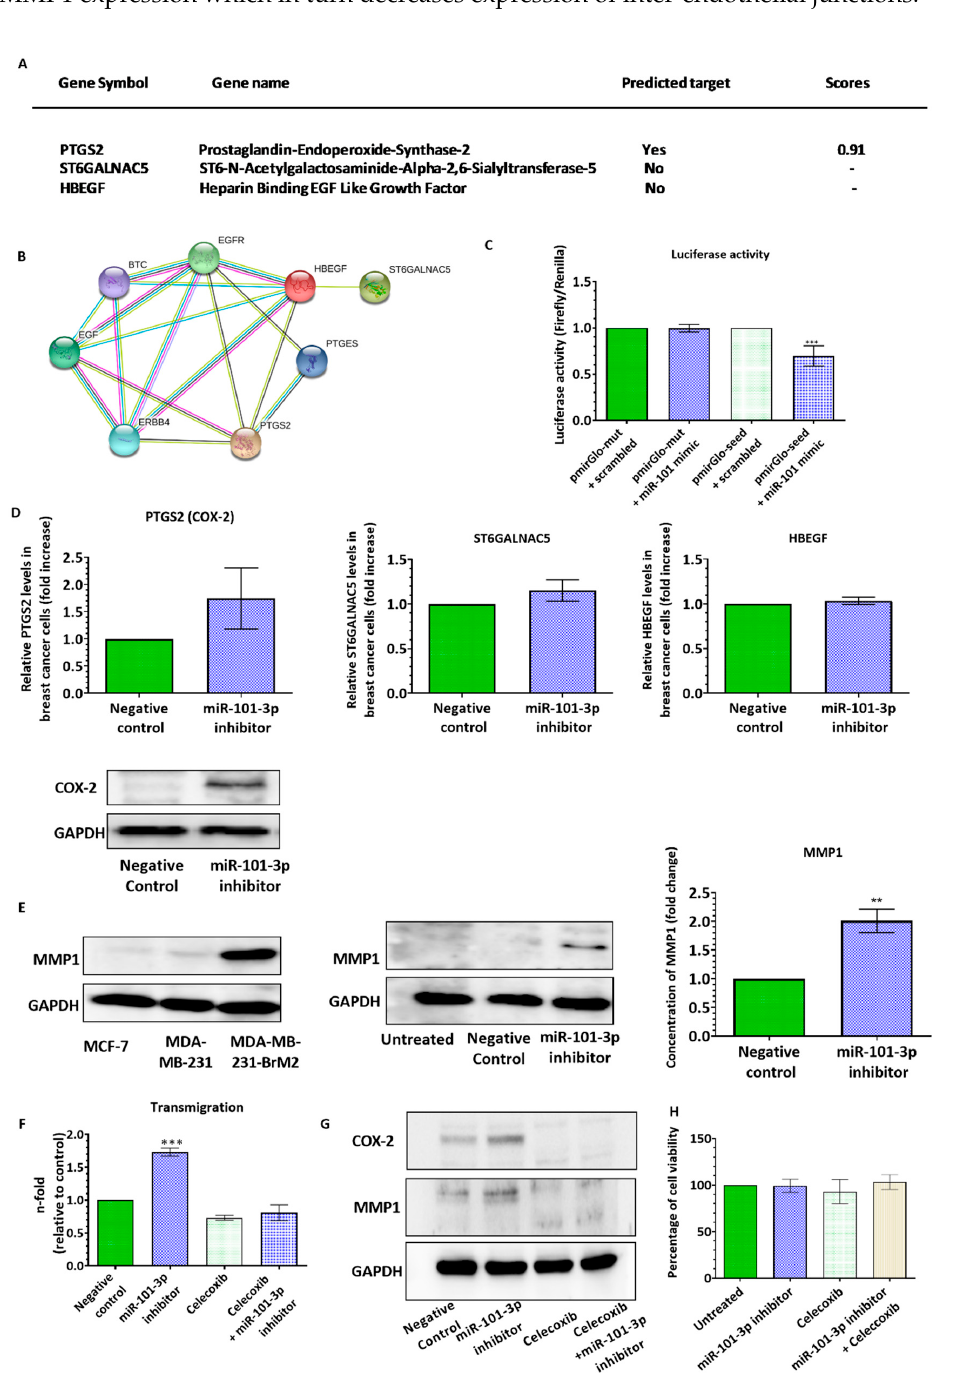
Figure 3. Ectopic downregulation of miR-101-3p in breast cancer cells promotes trans-endothelial migration through induction of COX-2-MMP1 expression. ( A ) List of has-miR-101-3p transendothelial migration-related predicted target genes in silico. ( B ) Protein–protein interaction network analysis retrieved from STRING (http://www.string-db.org/, version 9.1) showing the link between the different molecules involved in transmigration of breast cancer cells across the blood– brain barrier (BBB) (HBEGF, PTGS2 and ST6GALNAC5). Different colors of the lines represent the types of evidence for association: green line, neighborhood evidence; red line, fusion evidence; purple